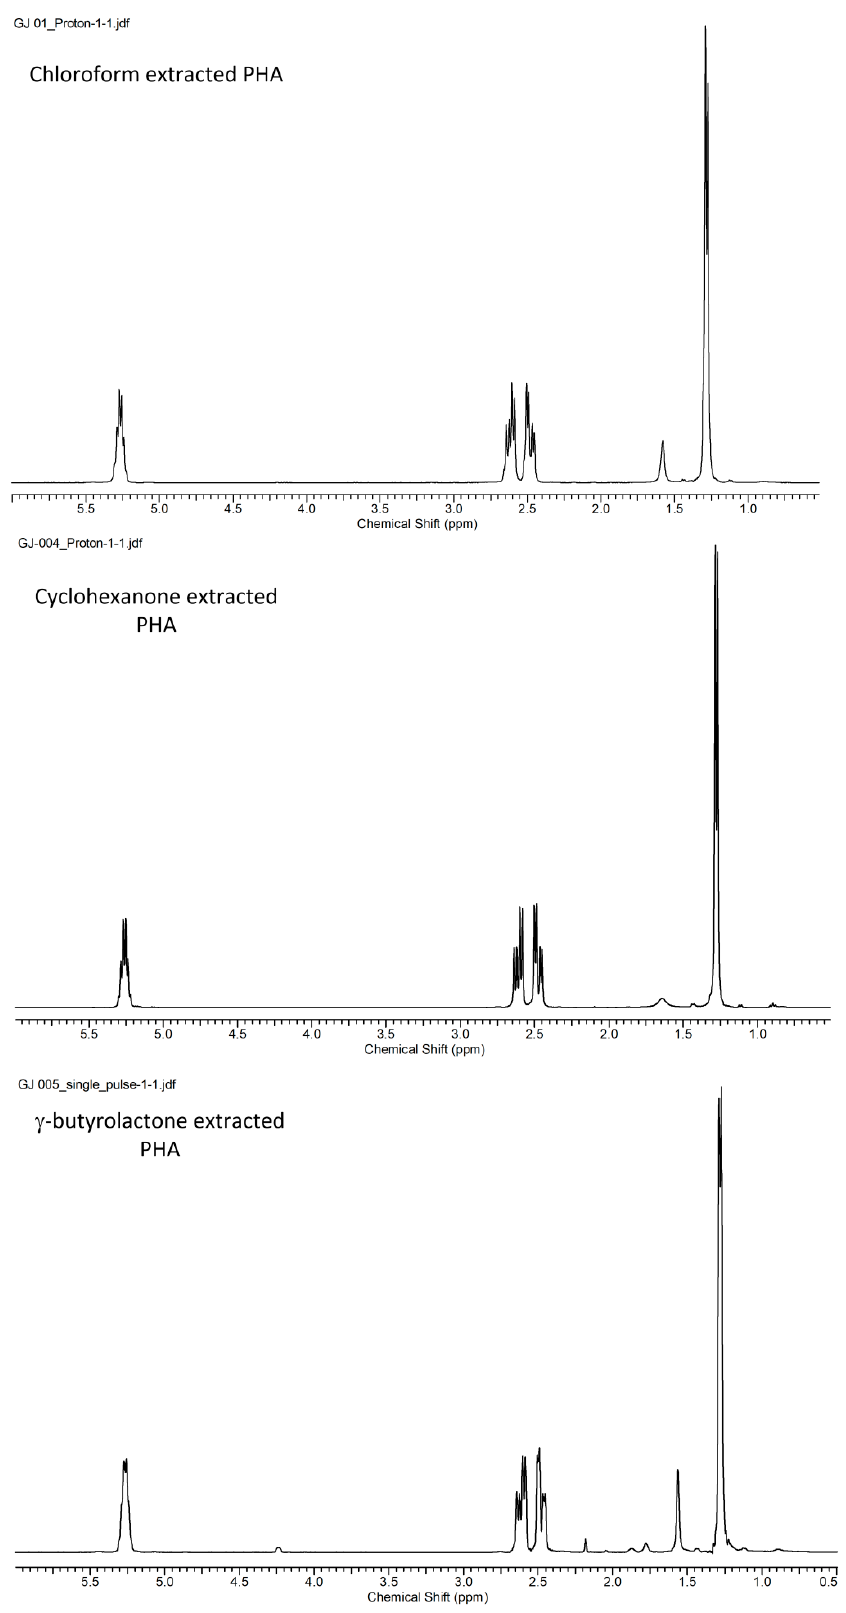
Figure 6. 1 H NMR spectra for the PHA extracted from the biomass using chloroform, CYC, and GBL, respectively.